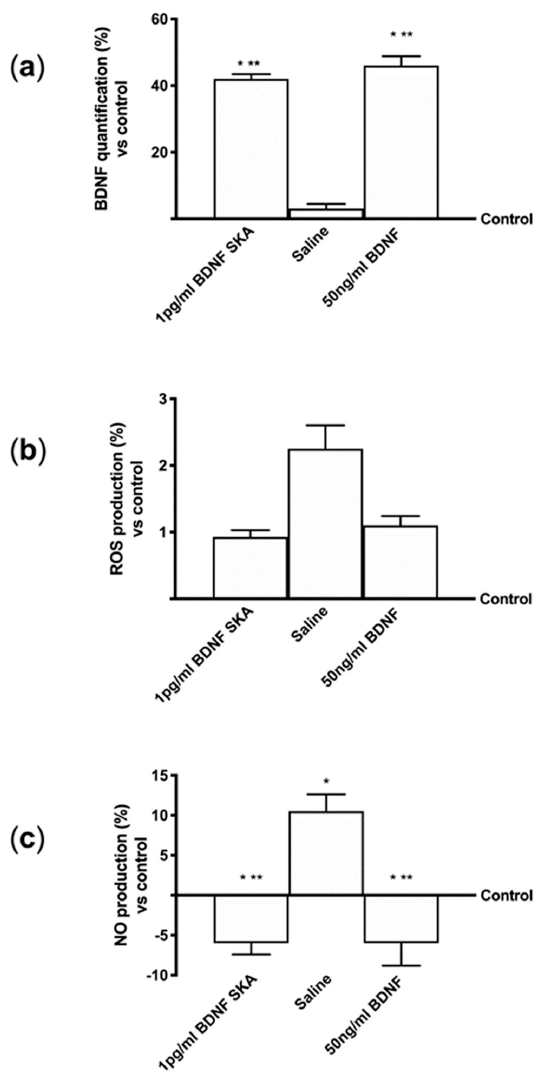
Figure 1. Analysis of the effects at blood–brain barrier (BBB) level. ( a ) Brain-derived neurotrophic factor (BDNF) quantification, ( b ) reactive oxygen species (ROS) production and ( c ) NO measurements are reported. Data are expressed as means ± SD (%) of four independent experiments performed in triplicates normalized to control (0 line as control). * p < 0.05 vs control; ** p < 0.05 vs saline solution.